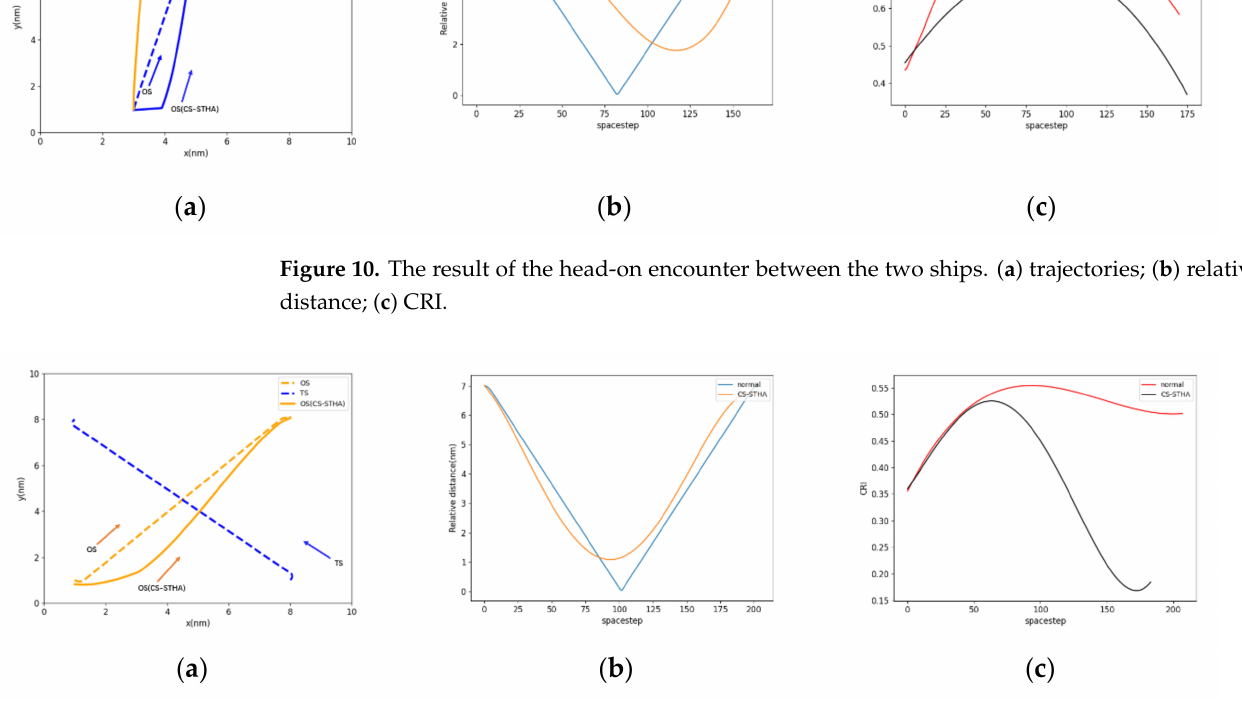
Figure 11. The result of the crossing encounter between the two ships. ( a ) trajectories; ( b ) relative distance; ( c )